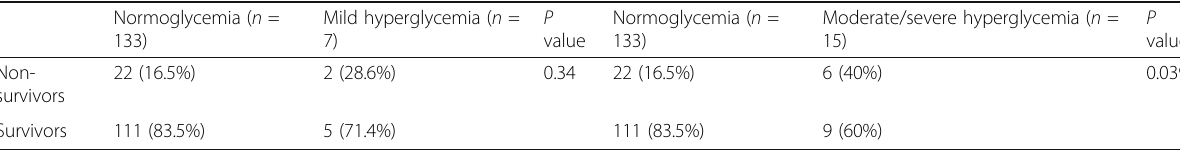
Table 4 The mortality rate according to the degree of hyperglycemia Normoglycemia ( n =